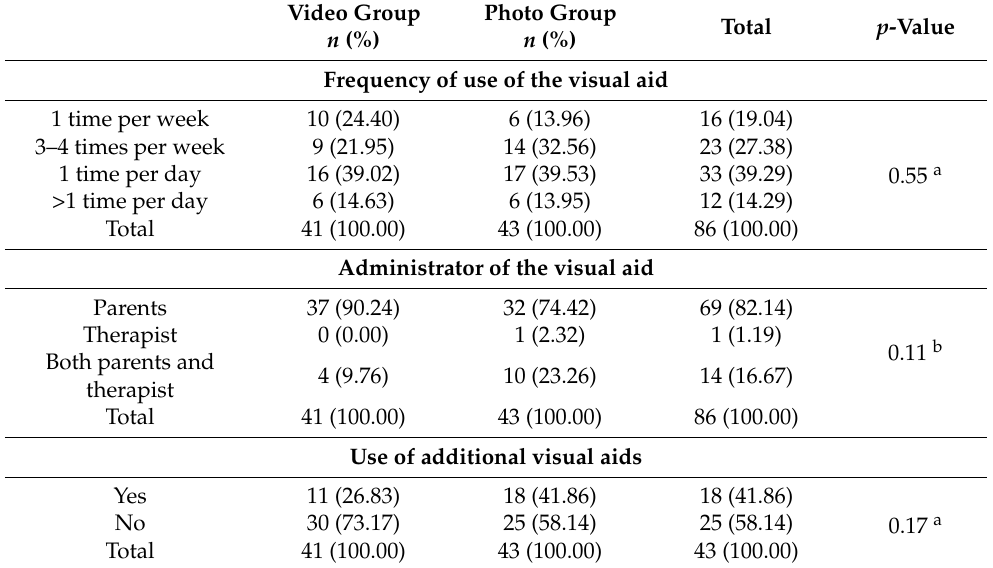
Table 1. Vital statistics including age, sex, autism severity, verbal fluency, previous use of visual pedagogy tools and caries status of the two groups.